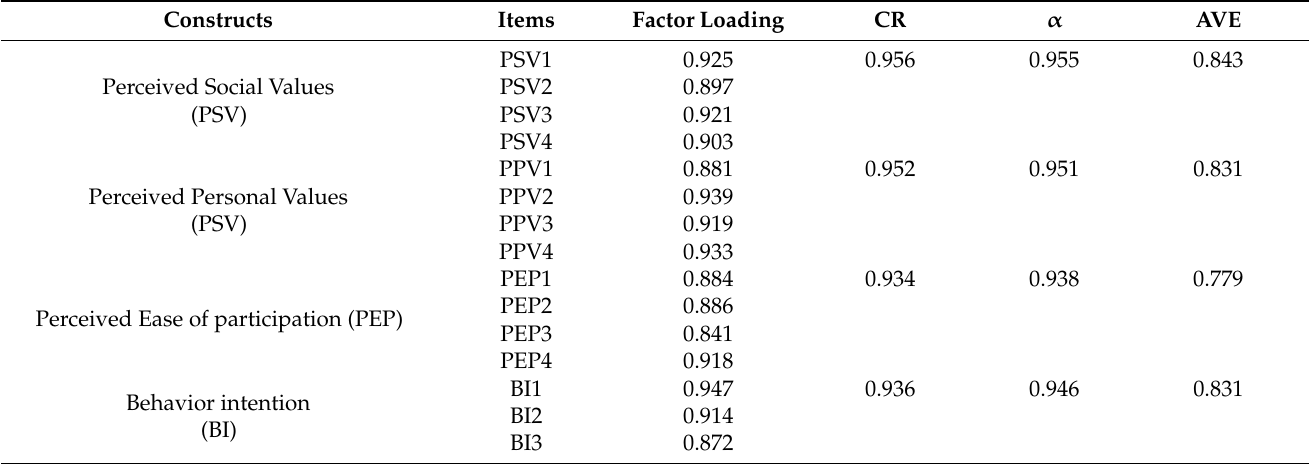
Table 4. Reliability and convergent validity